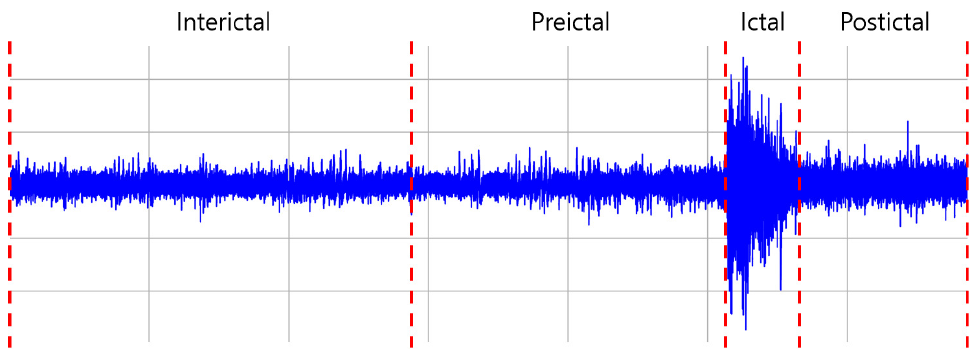
Figure 1. An example of epileptic brain states which contains an interictal part, preictal part, ic- tal part and postictal part.The horizontal axis displays the time and the vertical axis displays the measured